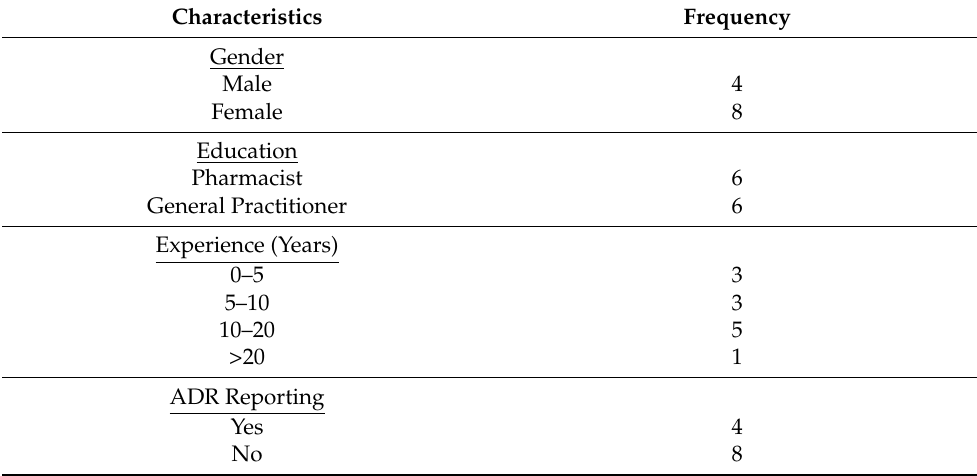
Table 1. Demographics of the